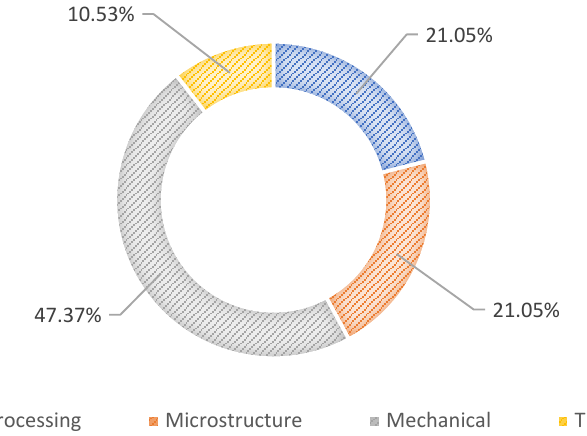
Figure A2. Intervention areas of the selected studies.